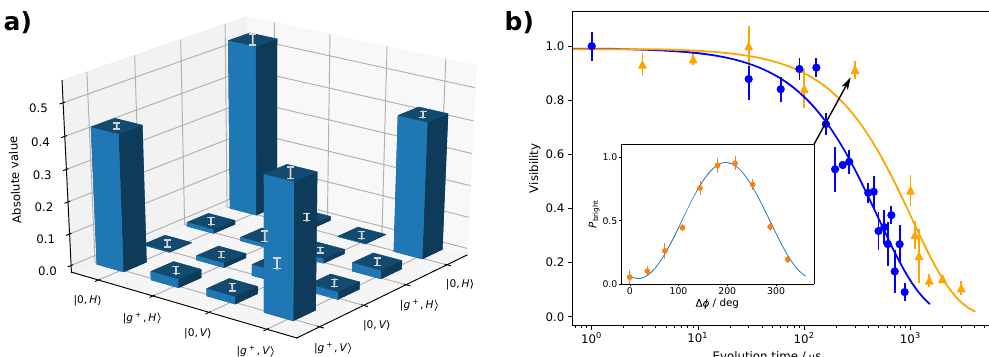
Fig. 3 Full quantum state tomography and coherence time of the atomic qubit. a Absolute values of the density matrix ρ obtained from a full quantum state tomography followed by a maximum likelihood estimation as described in methods. Errors are denoted with gray bars. b The experimental data show the visibility of a Ramsey like sequence for different evolution times between the two π /2 pulses. The visibility for each evolution time is determined by scanning the relative phase between the pulses (inset). Blue circles: The Zeeman qubit g ± j i exhibits a coherence time of (496 ± 42) μ s. Yellow triangles: The hyper fi ne qubit g þ j i = 0 j i exhibits a coherence time of (1022 ± 121) μ s. The times are extracted from fi ts (solid lines) with the function exp (cid:3) t = τ ð Þð Þ . Error bars show the standard